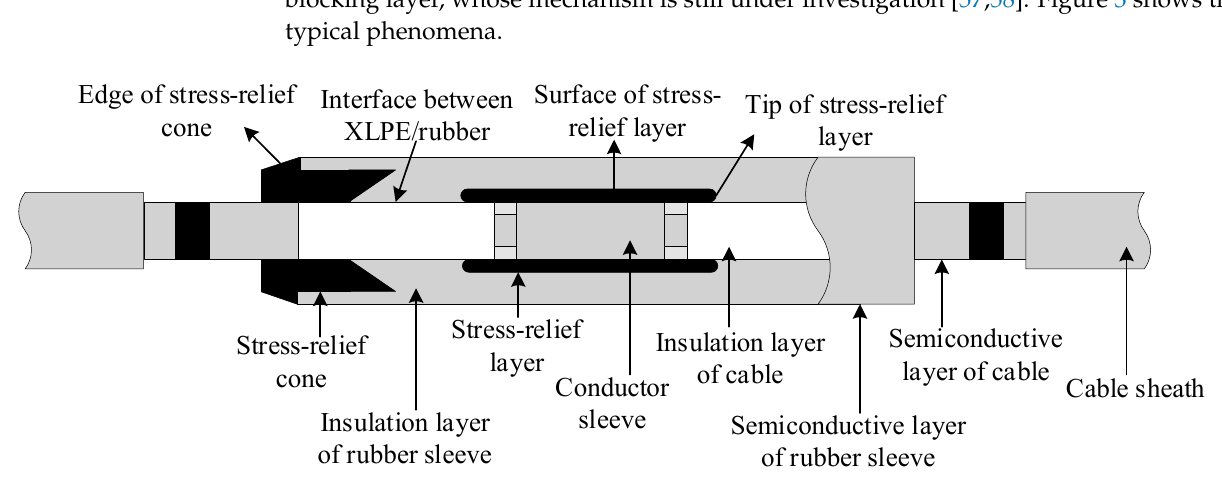
Figure 2. Illustration of cable joint design for electric stress control.